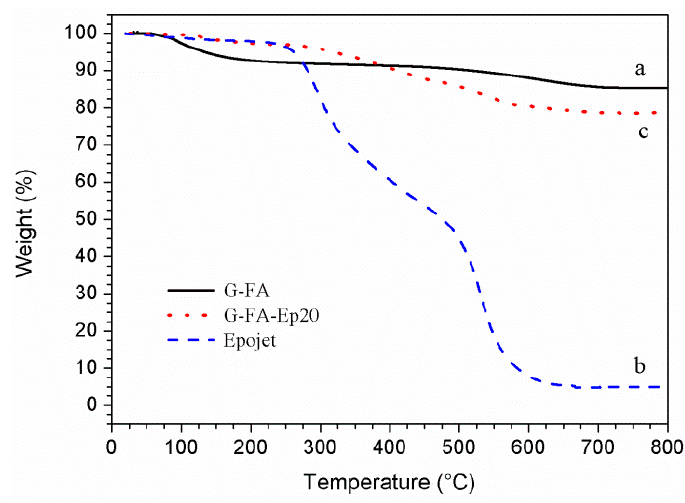
Figure 4. TGA curves of ( a ) the cured G-FA neat geopolymer sample ( black solid line); ( b ) the pure epoxy resins (Epojet, blue dashed line); and ( c ) the G-FA-Ep20 composite specimen ( red dotted line). Table 3. Thermal properties of the neat geopolymer (G-FA), pure epoxy resins (Epojet), and the composite specimen (G-FA-Ep20).